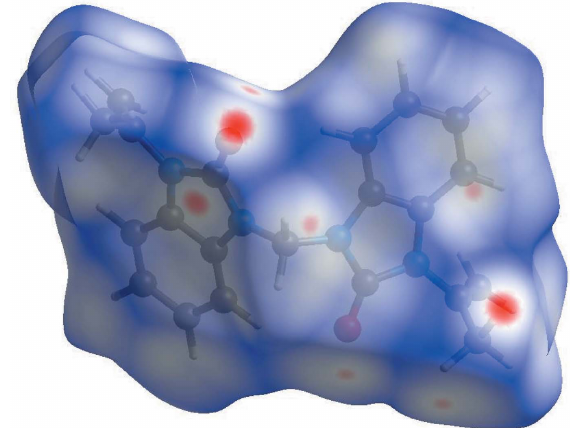
Figure 1 The title molecule with the labelling scheme and 50% probability ellipsoids. Intramolecular C—H (cid:2)(cid:2)(cid:2) O hydrogen bonds are shown as dashed lines.